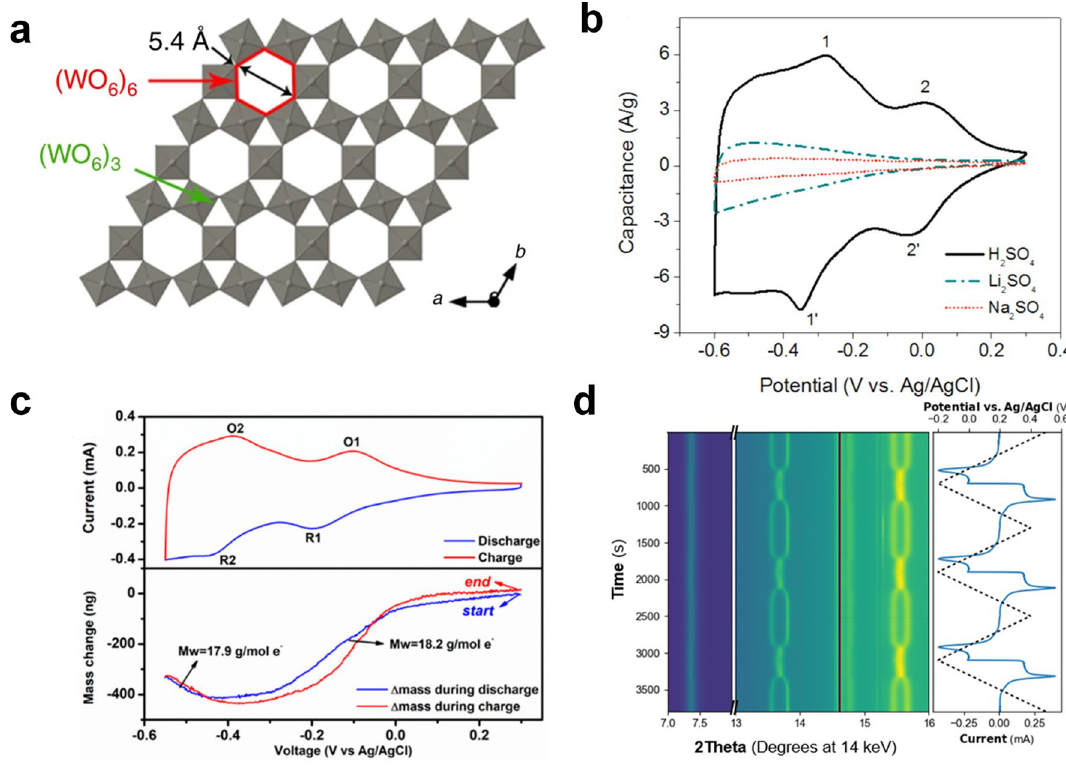
h -WO 3 [59]. Copyright 2019, Springer Nature. b CV curves of h -WO 3 ·0.6H 2 O in